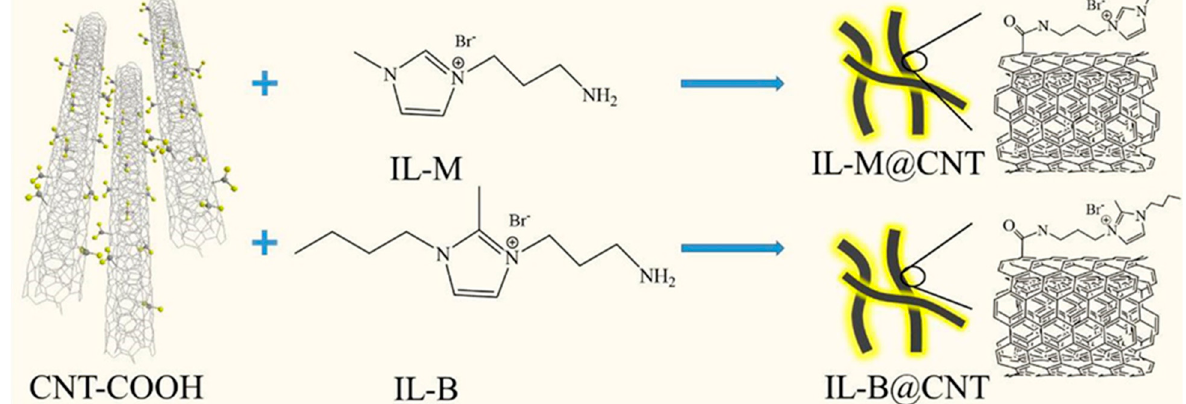
Figure 4. Synthesis of ionic liquids functionalized CNTs (IL ‐ (M;B)@CNT). Reproduced with permission from Ref. [34].